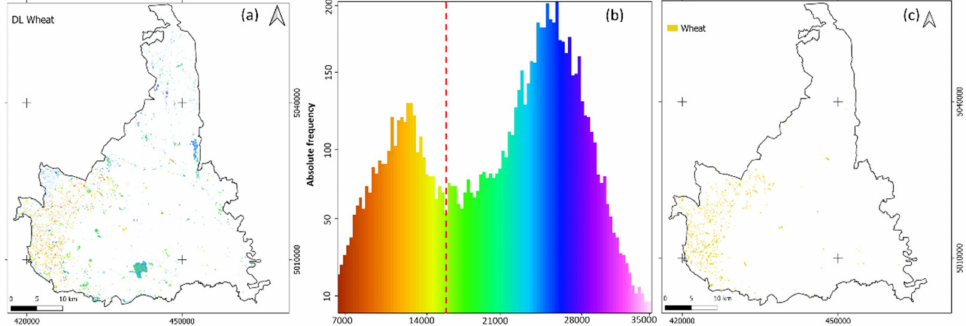
Figure 7. ( a ) DL map of wheat. ( b ) Wheat DL map frequency histogram (units are NDVI × 10,000). Red line is threshold found by OM. ( c ) Fields classified as wheat (reference system is WGS84/UTM 32N, EPSG: 32632).